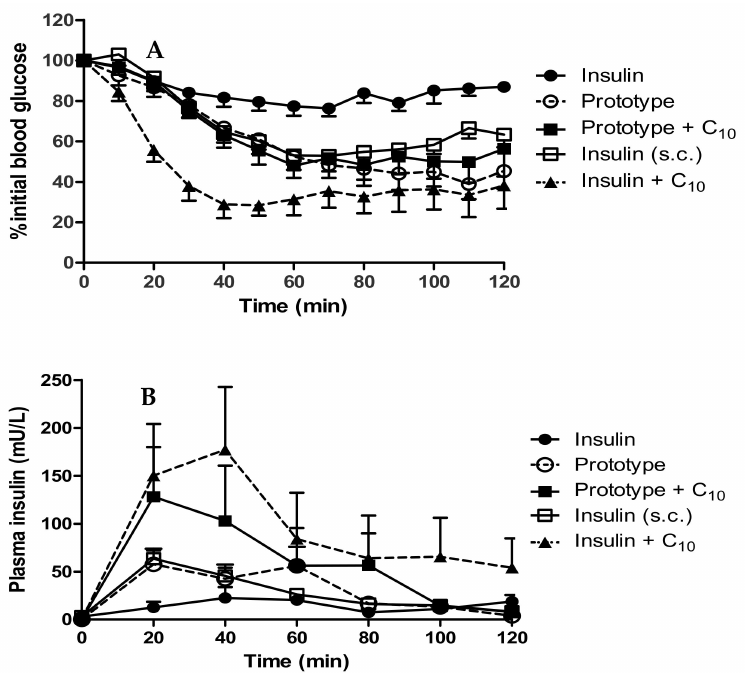
Figure 8. ( A ) Reduction in blood glucose; ( B ) Plasma insulin levels in rats following i.j. instillation of prototype dWPI-insulin beads with and without C 10 . Doses: 50 IU/kg insulin, C 10 (100 mM) (both